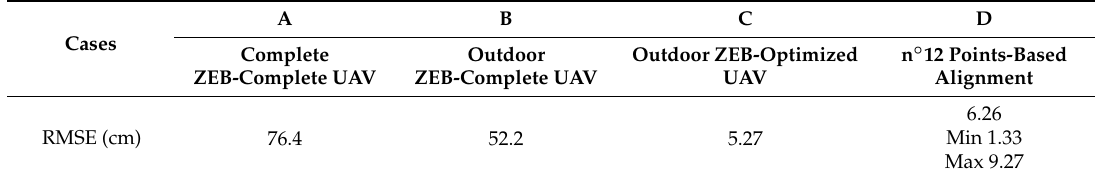
Figure 13. Complementary representation of C2C points distances between the two point clouds: ( a ) ZEB distances on UAV data (min. 1.33 cm, Max. 9.27 cm) and ( b ) vice-versa projection and values in Table 6. Results of C2C comparison ZEB point cloud and UAV Digital Surface Model (UAV DSM) on the Rocca volumes.